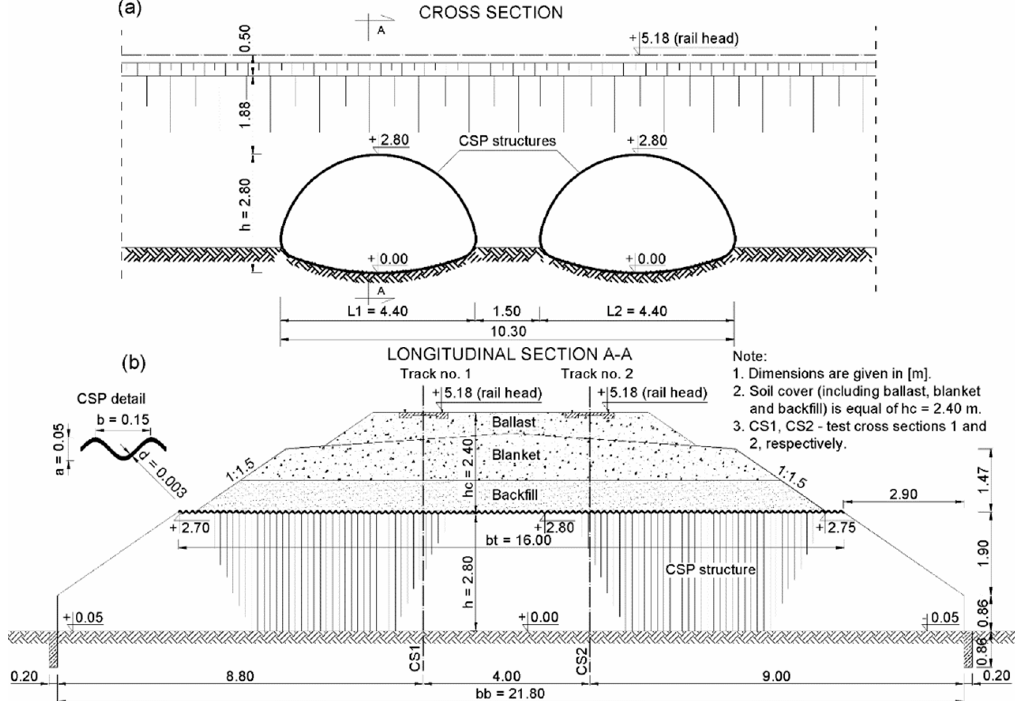
Figure 2. Analyzed soil–steel bridge located in Krosnowice, Poland.